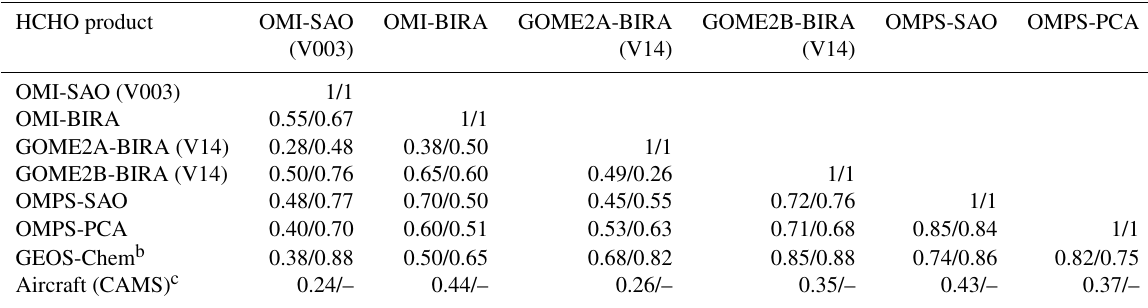
Aircraft (CAMS) c